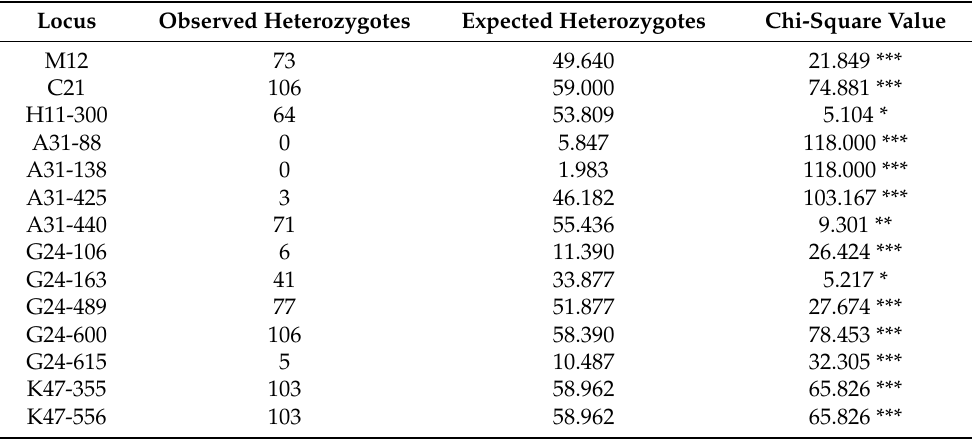
Table 3. Chi-Square Tests for Hardy–Weinberg Equilibrium using the total A. exitialis sample. Locus Observed Heterozygotes Expected Heterozygotes Chi-Square Value